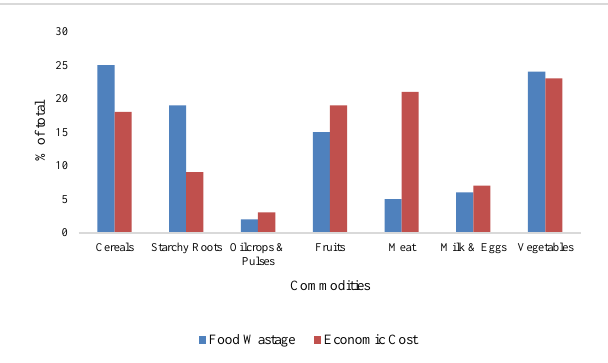
Figure 7: Economic Cost due to wastage of each Commodity (FAO,